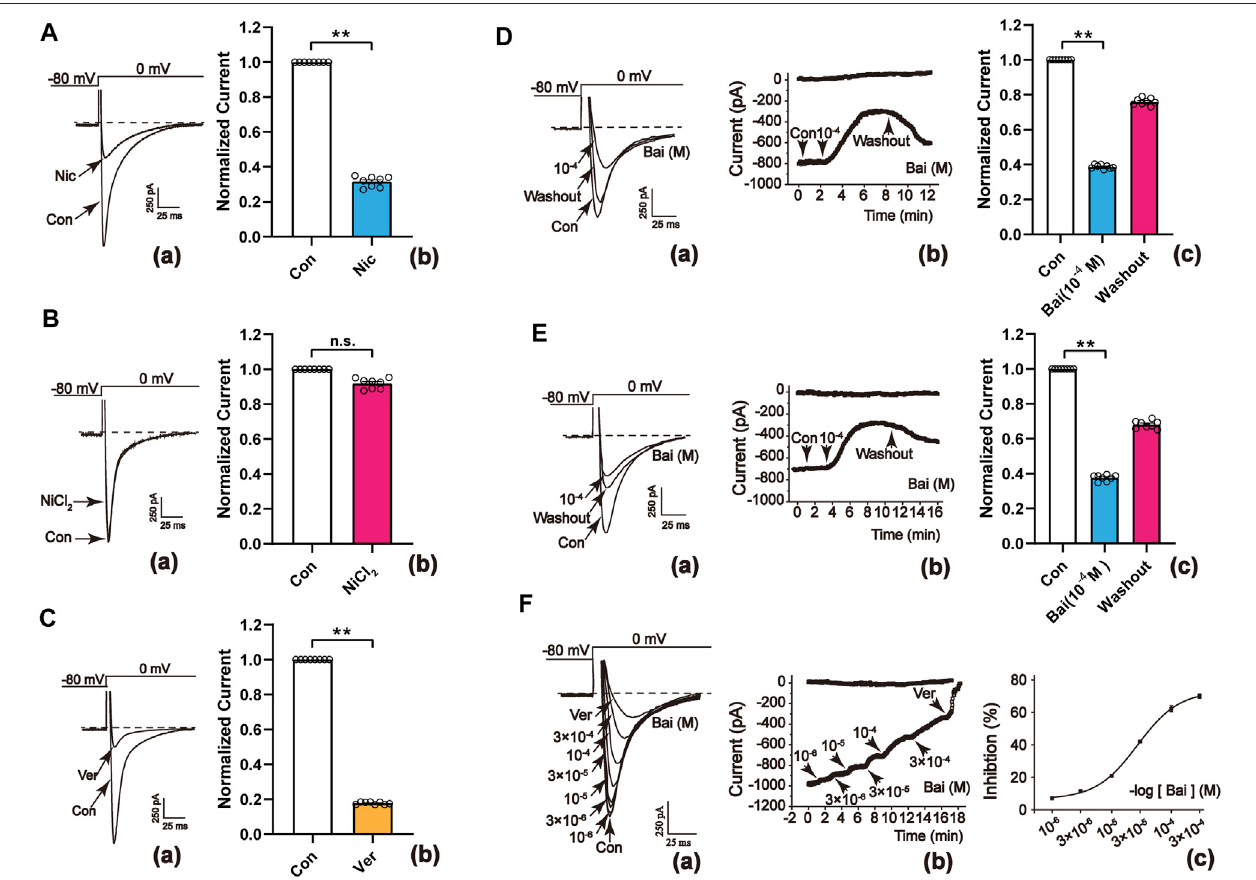
FIGURE 7 | Con fi rmation of L-type Ca 2+ currents in rat cardiomyocytes. (A – C[a]) Typical traces and (A – C[b]) summary data exhibited the representative L-type Ca 2+ currents recordings with the application of (A) Nic (10 − 3 M) (B) NiCl 2 (10 − 2 M), and (C) Ver (10 − 6 M). Nic and Ver almost totally blocked the L-type Ca 2+ currents. Effects of Bai on L-type Ca 2+ currents in (D) normal ventricular myocytes and (E) ischemic ventricular myocytes. (D,E[a]) Typical traces (D,E[b]) temporal course of L-type Ca 2+ currents, and (D,E[c]) summary data were recorded in the control conditions, during applications of Bai (10 − 4 M) and washout. (F[a]) Current traces and (F[b]) the temporal course of L-type Ca 2+ currents were recorded in the control conditions during exposure to 10 − 6 , 3 × 10 − 6 , 10 − 5 , 3 × 10 − 5 , 10 − 4 , and 3 × 10 − 4 M Bai, and 10 − 6 M Ver. (F[c]) Concentration-response curve representing the percent inhibition of Bai. Values are expressed as means ± S.E.M. p < 0.01 versus Con, n = 6-8 cells.